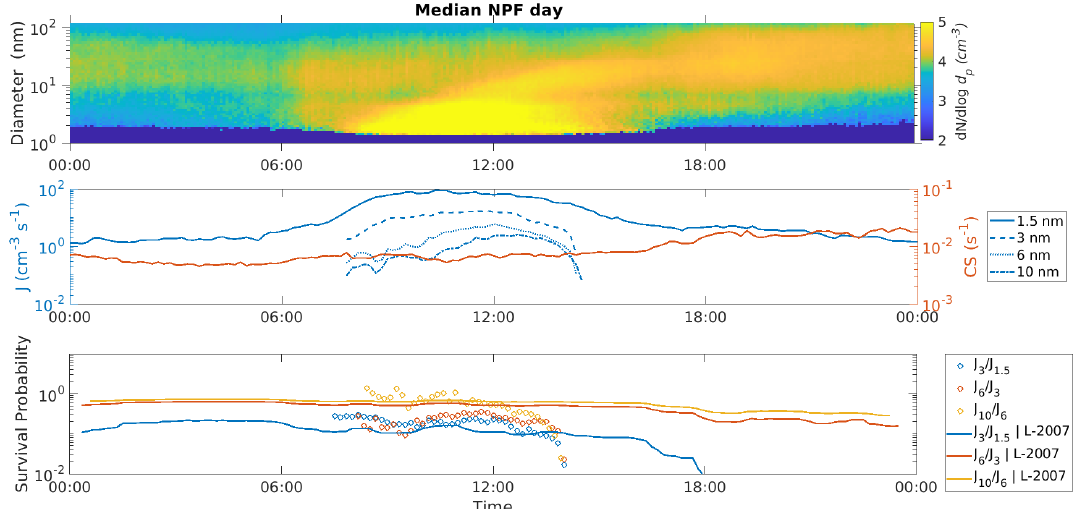
Figure 6. The median particle number size distribution and the median survival probabilities from 1.5 to 3nm ( J 3 /J 1 . 5 ), from 3 to 6nm ( J 6 /J 3 ), and from 6 to 10nm ( J 10 /J 6 ) during an NPF event day in Beijing, China. Theoretical predictions (L-2007) for survival probability based on the Lehtinen et al. (2007) formulation (see Eq. 2) determined on the basis of the median condensation sink (CS) and the median growth rate (GR) are also shown. The median GR is 2.48nmh − 1 between 1.5 and 3nm, 4.81nmh − 1 between 3 and 6nm, and 3.37nmh − 1 between 6 and 10nm.